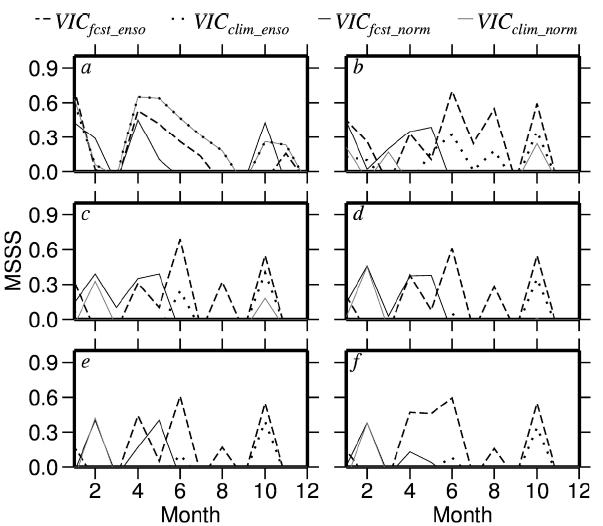
Fig. 7. Same as Fig. 5, but MSSS calculated separately under ENSO conditions (VIC fcst , VIC clim ) and normal tropical Pacific enso enso ) conditions. , VIC clim (VIC fcst norm norm